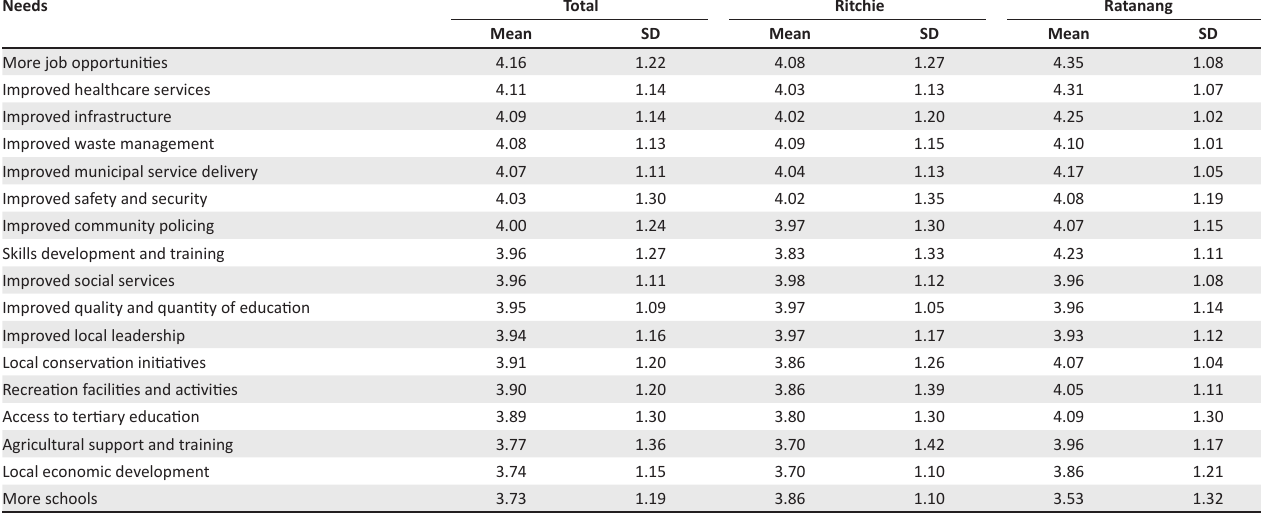
TABLE 3: Needs of total group and two communities. Needs